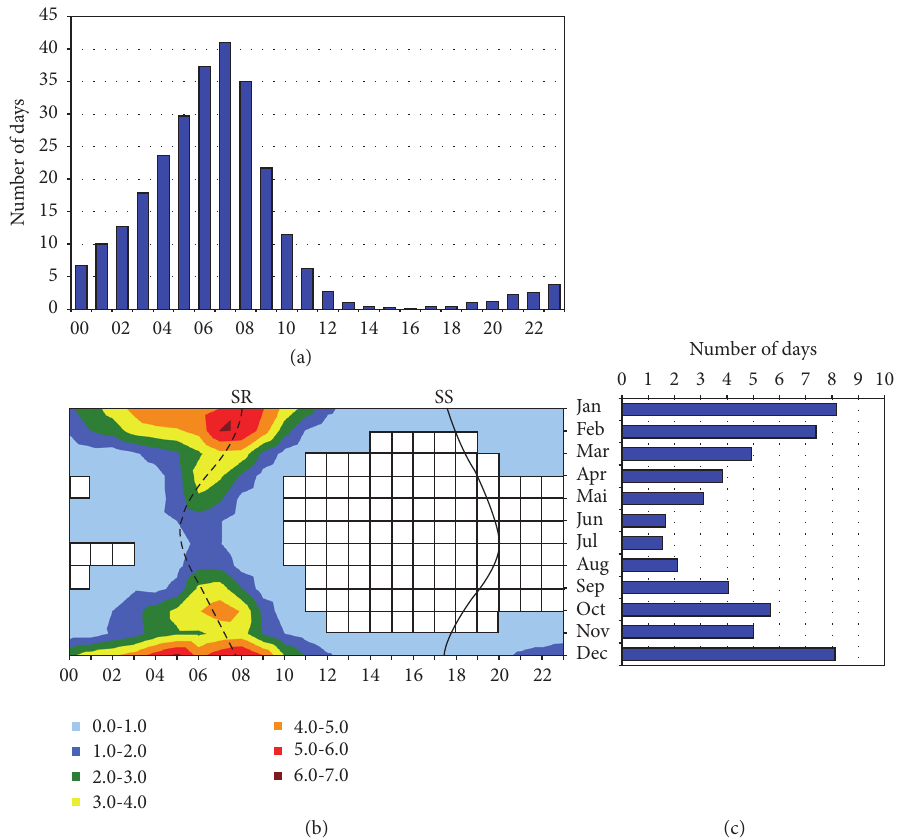
Figure 5: Mean number of days with fog over the entire year in Beja Air Base (2006–2012) by (a) hour, (b) hour and month, and (c) month. Hours in UTC. SR: sunrise; SS: sunset.